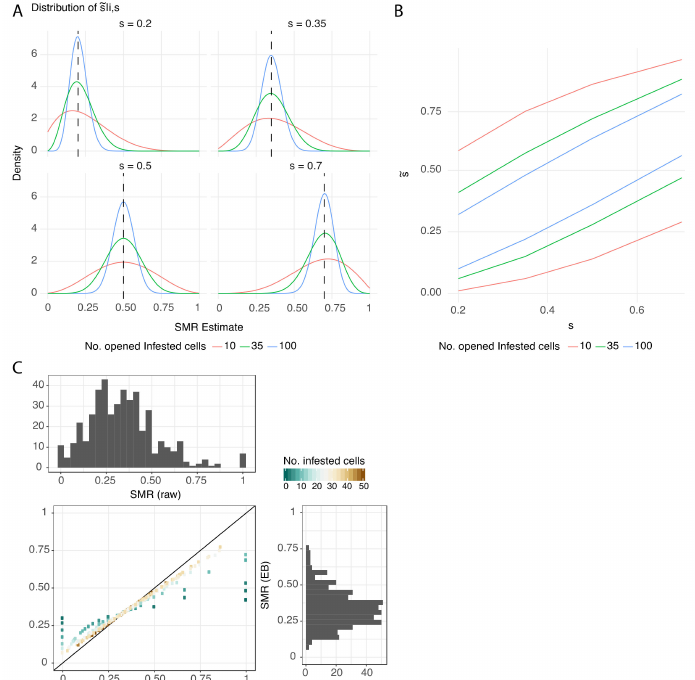
Figure 3. SMR estimates reliability. ( A ) Density of distribution of the SMR estimate, depending on the SMR value (s = 0.2, 0.35, 0.5 or 0.7) and the number of opened single-infested cells (SIC, no. of SIC = 10, 35, or 100). ( B ) Precision of the SMR estimate (95% quantiles), depending on the SMR estimate. Three examples of SIC numbers are represented (10, 35, and 100) to illustrate the fact that using 10 SIC does not give a reliable SMR estimate. ( C ) “Empirical Bayes” (EB) distribution with the initial distribution of raw SMR values (top) and comparison to the EB estimates. The distance to the identical distribution (black line) is acceptable when the number of SIC is greater than 30 (pale